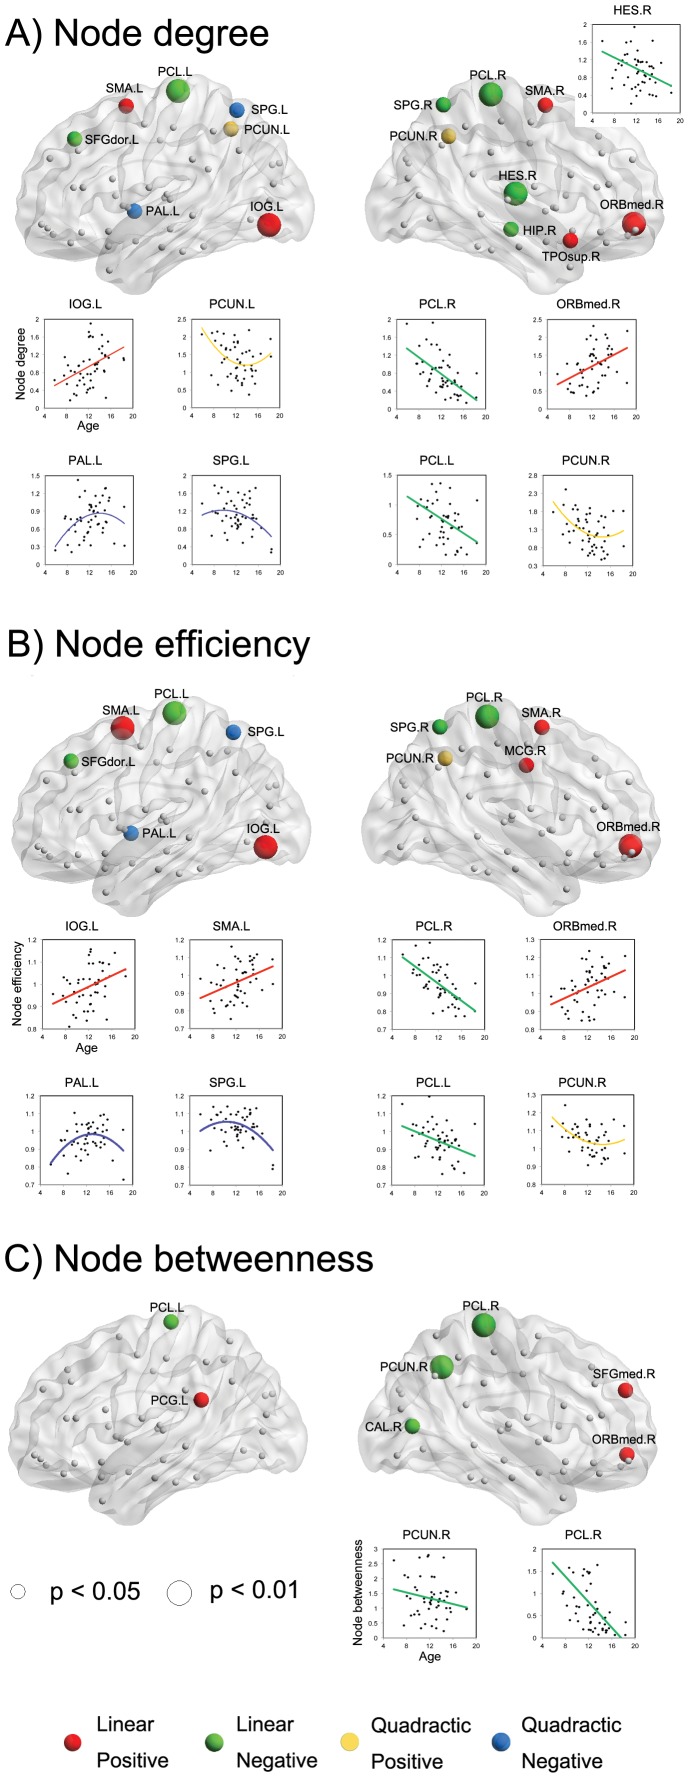
Effect of age on regional nodal properties.Significant linear positive, linear negative, quadratic positive, and quadratic negative correlations are indicated by red, green, yellow, and blue spheres, respectively. The significances of p<0.05 and p<0.01(uncorrected) are shown by spheres in small and big size, respectively. For a description of the abbreviations, see Table S1.